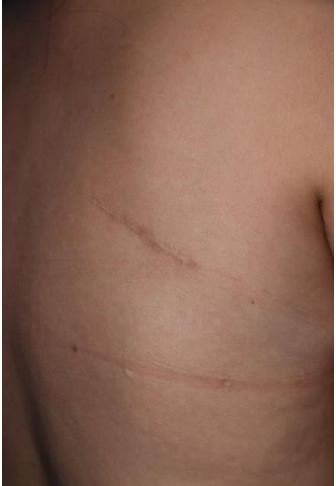
Figure 6. Image obtained 3 years after the second excision. There is no recurrence.